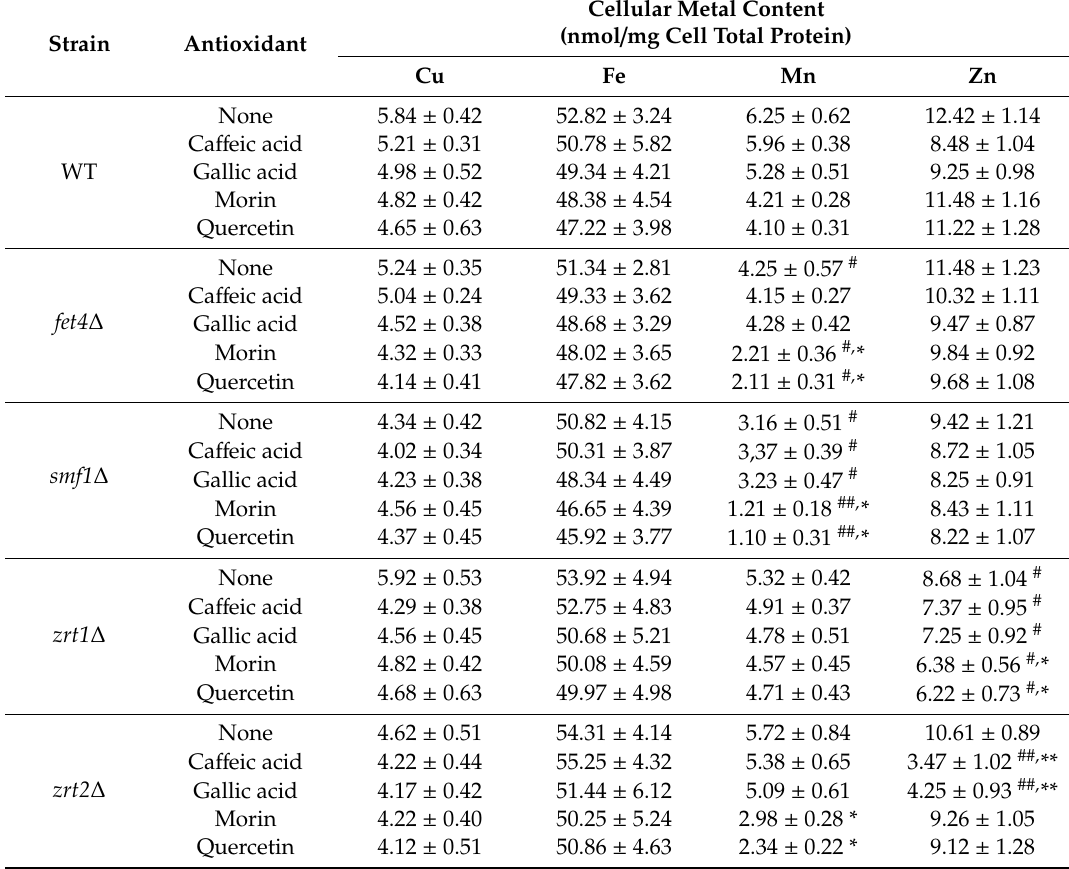
Table 2. E ff ect of polyphenols on metal content of yeast cells. Exponentially growing cells were washed and shifted to MM (OD 600 = 0.1) in the absence or presence of the antioxidants (100 µ M each, final concentration). Cells were grown with agitation (30 ◦ C, 200 rpm) for 16 h before being harvested for multielemental analysis. Each determination was done in triplicate on approximately 10 8 cells from three biological replicates. Results are given as mean ± SEM (standard error of the mean). The level of significance was determined by one sample t -test, when each strain was compared with WT under the same conditions (hash sign, # ) or with the same strain grown without polyphenol (asterisk,